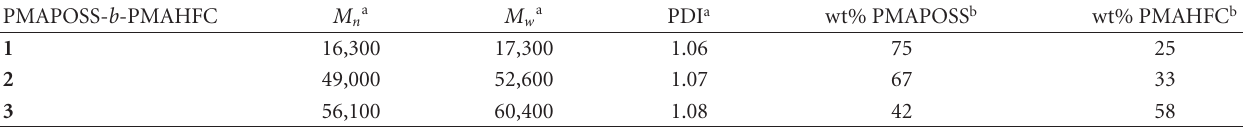
integrations from 1 H NMR